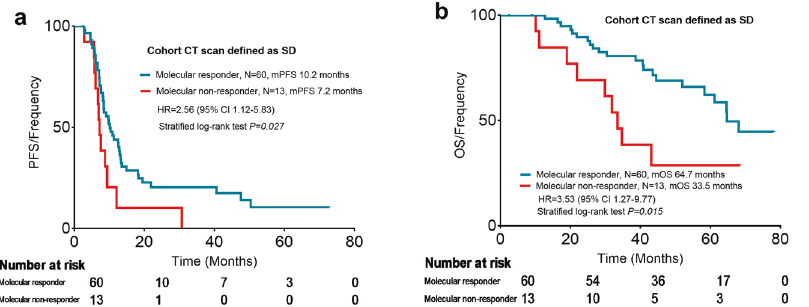
Fig. 5 Survival analysis in the cohort CT scan de fi ned stable disease. a PFS analysis based on early response according to the mTBI in the cohort with CT scan de fi ned stable disease. b OS analysis based on early response according to the mTBI in the cohort with CT scan de fi ned stable disease. CT computed tomography, SD stable disease, mTBI molecular tumor burden index, PFS progression-free survival, OS overall survival, HR hazard ratio, CI con fi dence